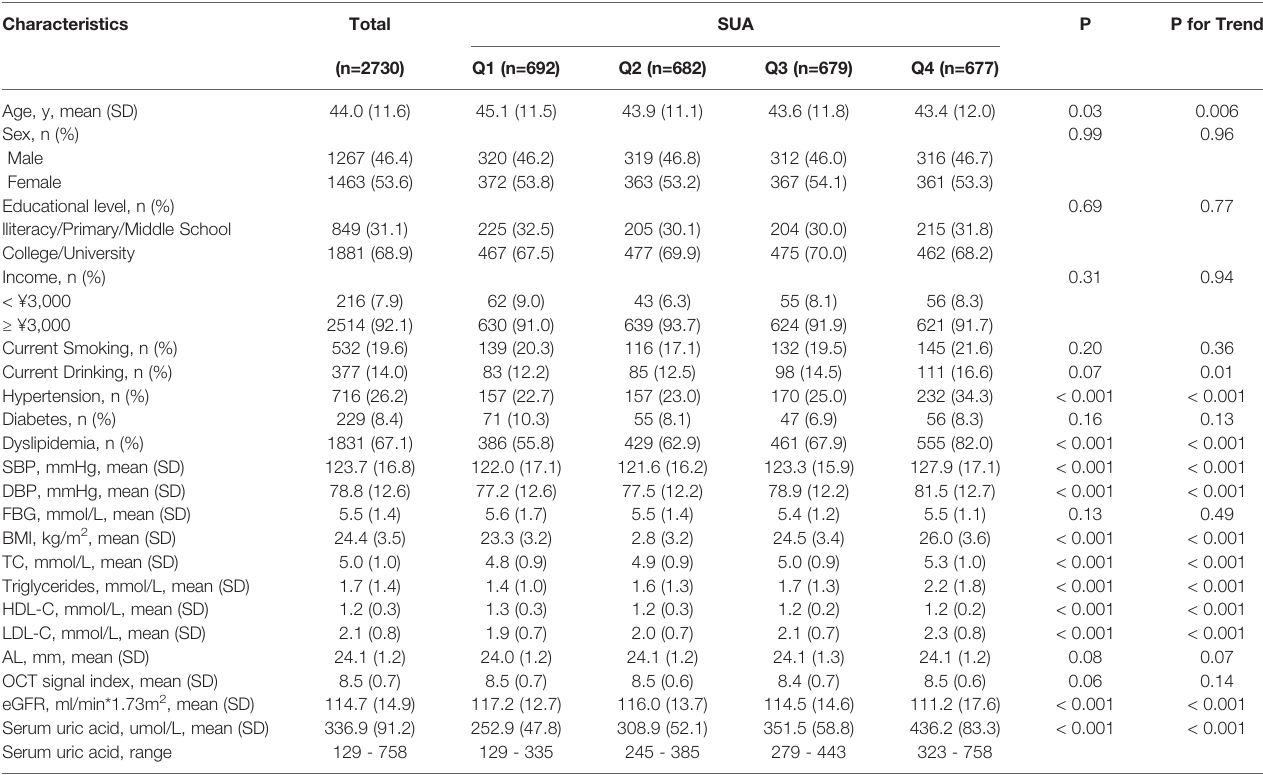
TABLE 1 | Baseline characteristics of participants by serum uric acid quartiles.